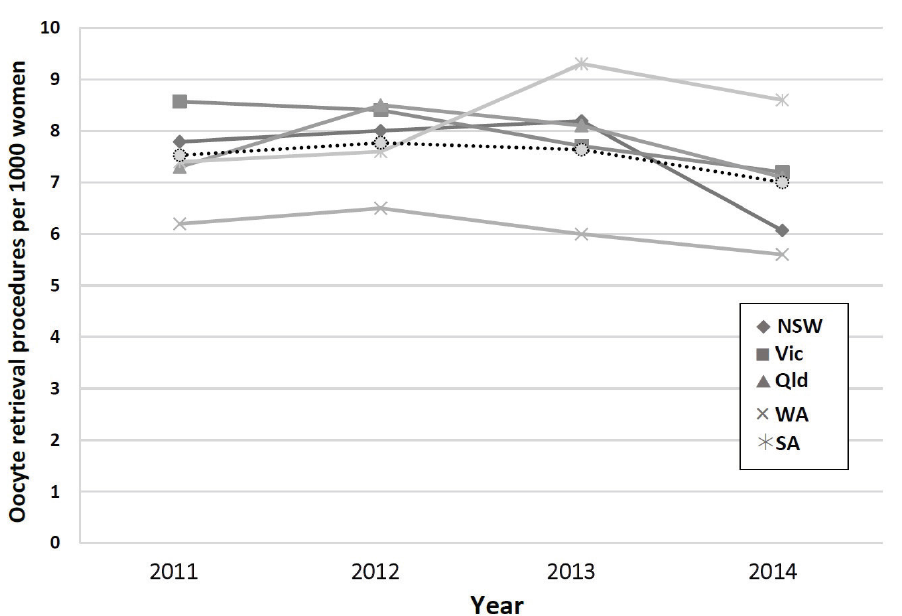
Figure 1. Age-stratified incidence rate of in vitro fertilisation (IVF) cycles proceeding to oocyte retrieval in women aged 24 to 35 years in Australia (oocyte retrieval procedures per 1000 women per year), 2011 to 2014 inclusive